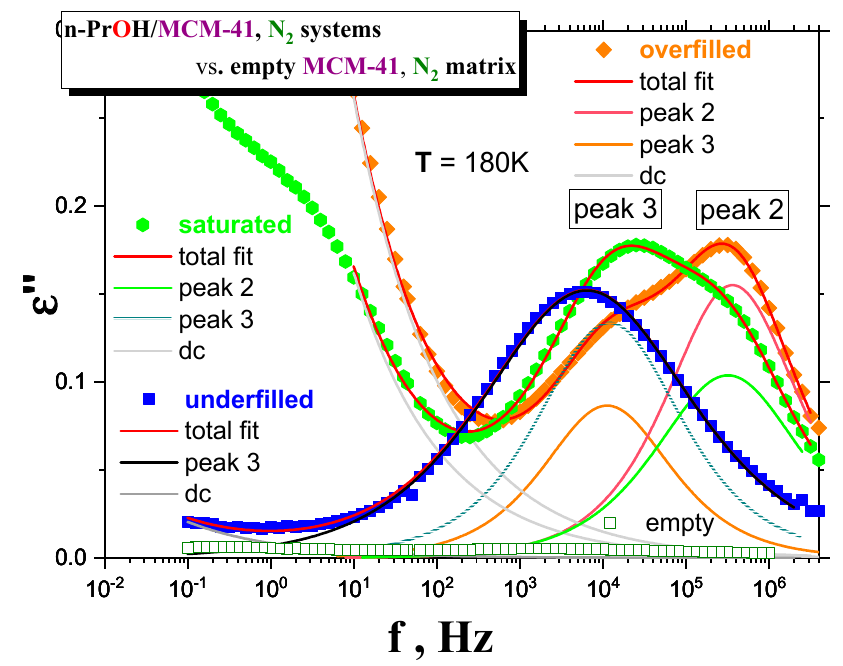
Figure 5. Comparison of the BDS spectra at 180 K for underfilled, saturated and overfilled n- PrOH/MCM-41, N 2 systems, as well as for empty MCM-41, N 2 and n-PrOH after cooling with − 2 K/min from RT down to 100 K and subsequently isothermal heated with Δ T = 5 K step up to 300 K. Spectral fits using Equation (1) are included.